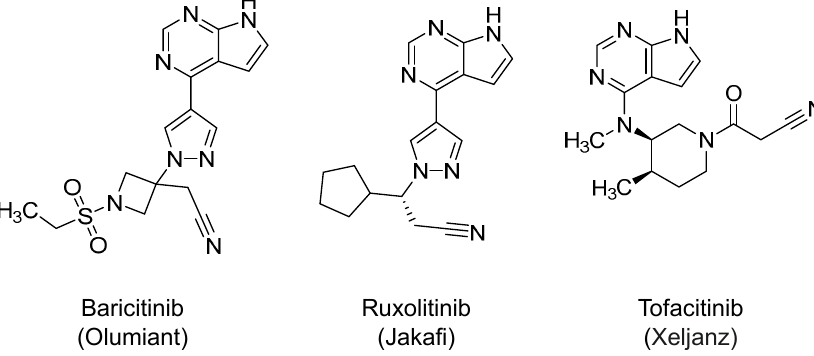
Figure 11. The chemical structures of pyrrolo-pyrimidine-based JAK inhibitors. The drugs potentially block clathrin-mediated endocytosis of the virus. They also exhibit anti-inflammatory / immune-modulatory agents.